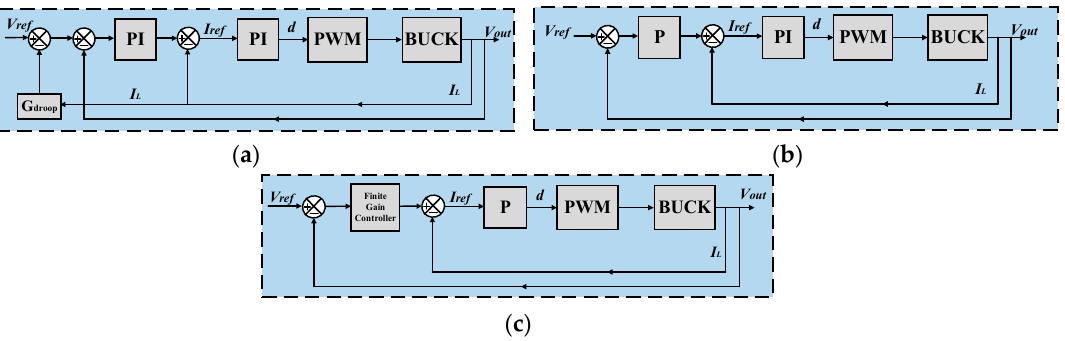
Figure 6. Small signal models of existing and proposed control techniques: ( a ) small signal model of droop-based technique [12], ( b ) small signal model of improved cooperative technique [13], and ( c ) small signal model of the proposed technique.